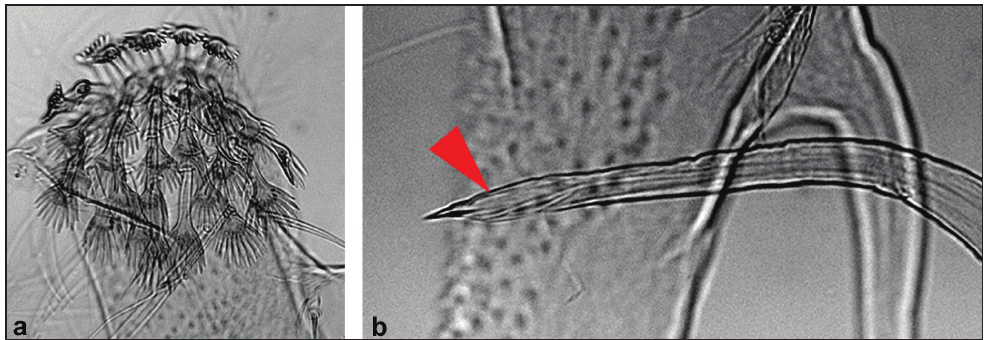
Figure 3. Anarsia male genitalia. a. Palmate scales at distal part of left valve; b. Tube at right valva with distal opening.